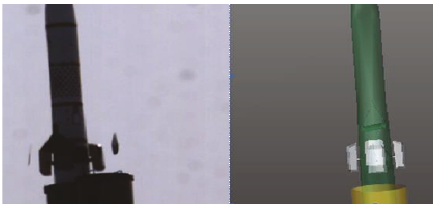
Figure 6: The comparison of experiment and simulation at 0.2061s.